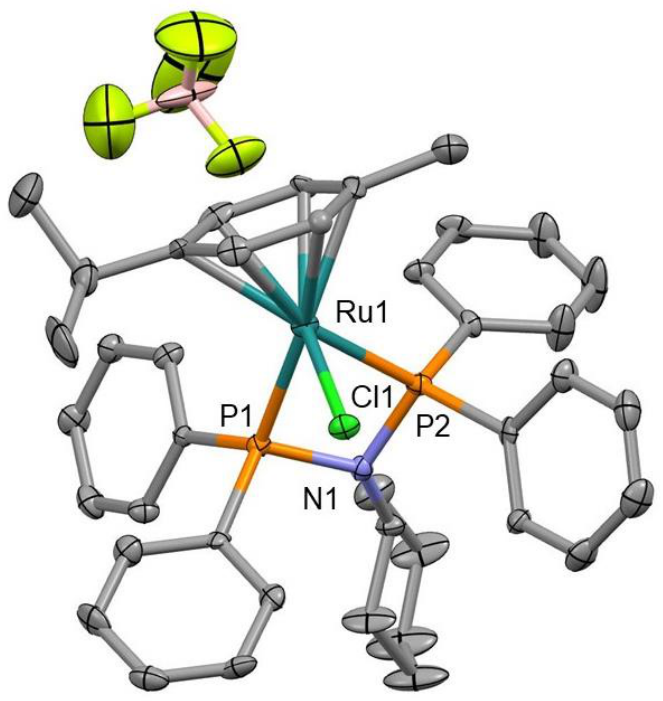
Figure 3. MERCURY plot for the structure of complex Ru3. Thermal ellipsoids are given at the 30% probability level. Hydrogen atoms have been omitted for clarity. Selected bond distances (Å ), Ru1 –